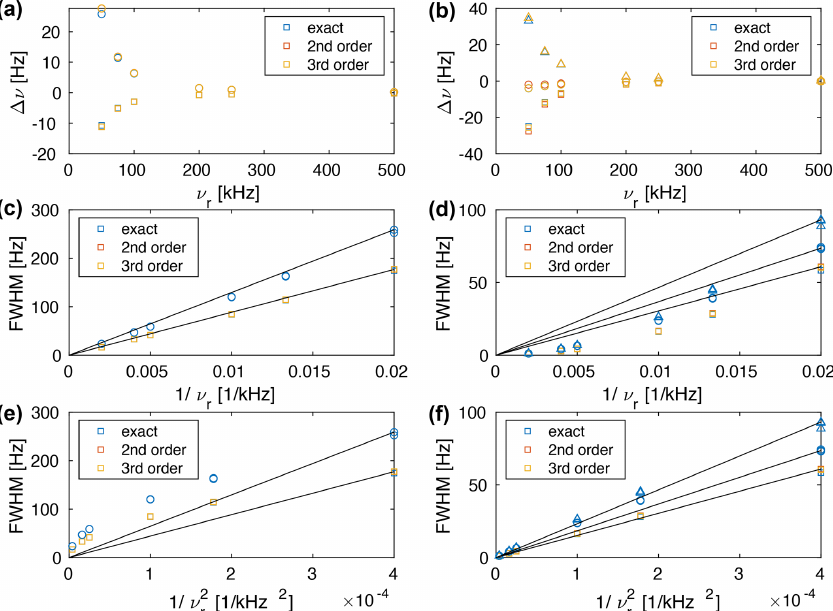
Figure 6. (a, b) Plot of the deviation of the calculated chemical shift (first moment of the line) from the theoretical chemical shift. Plot of the line width (FWHM) as a function of (c, d) ν − 1 r and (e, f) ν − 2 r . The spin-system parameters are δ 12 / (2 π ) = − 44826Hz, δ 13 / (2 π ) = − 8898Hz, δ 23 / (2 π ) = − 5750Hz, θ 13 = 90 ◦ , θ 23 = 120 ◦ . The chemical shifts were chosen to be (a, c, e) δ 1 = δ 2 = 0ppm (squares), δ 3 = 0.7ppm (circles) and (b, d, f) δ 1 =− 0 . 1ppm (squares), δ 2 = 0.2ppm (circles), δ 3 = 0.7ppm (triangles) at a Larmor fre- quency of 1GHz. The straight lines go through (0,0) and the line width at the slowest spinning frequency. They are meant as a guide to the eye for the linear